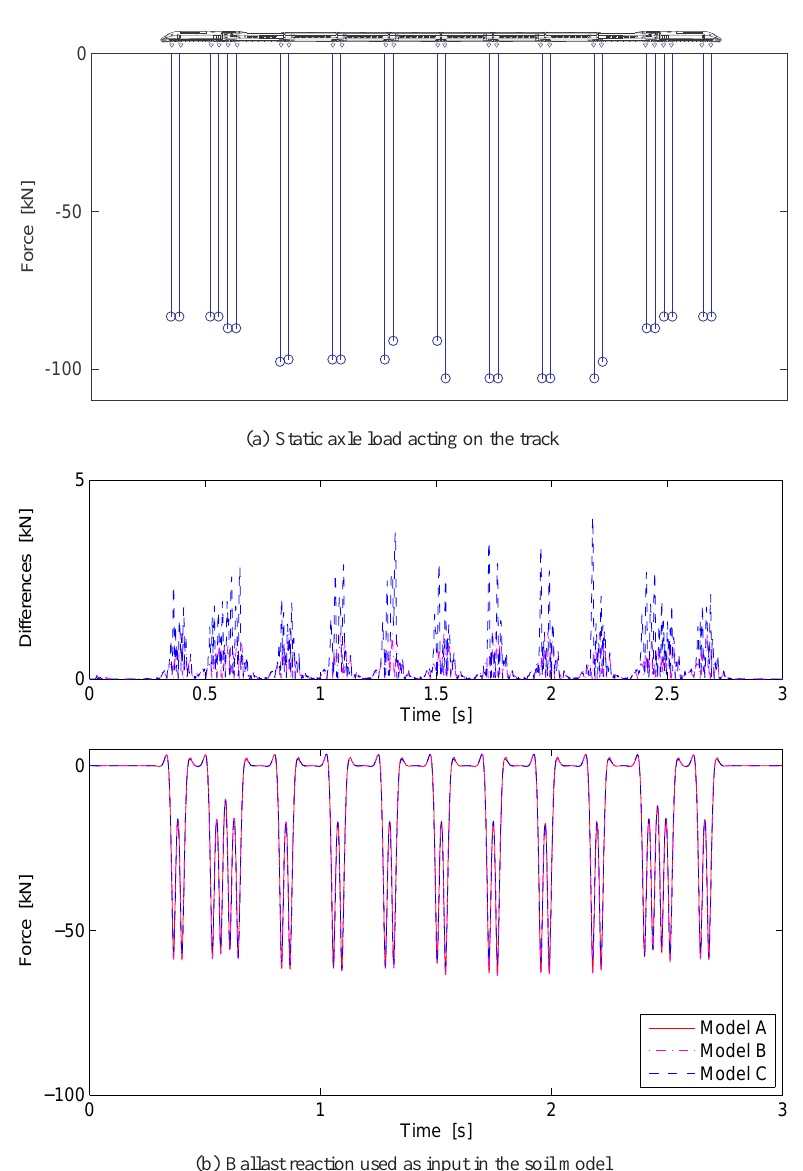
Figure 13. Time history of track / foundation forces for each model